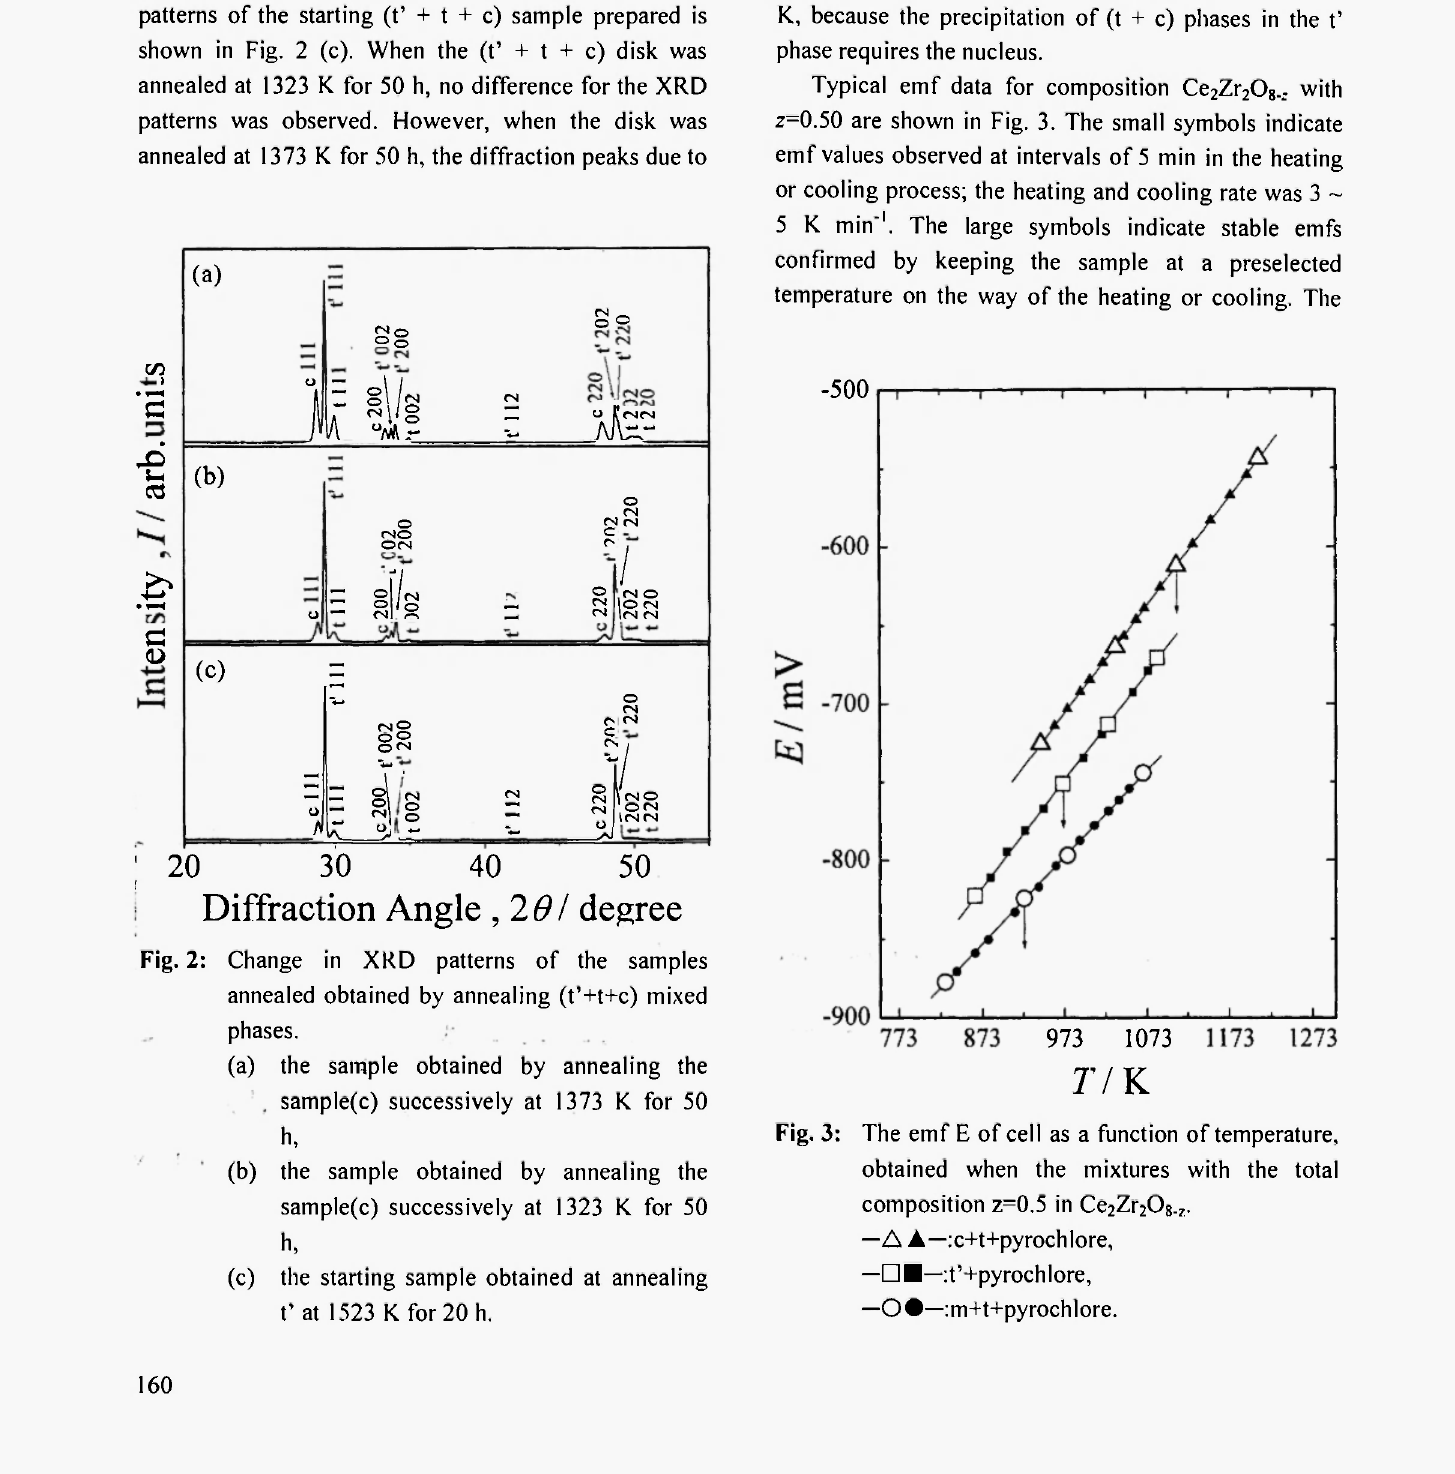
Fig. 3: The emf Ε of cell as a function of temperature, obtained when the mixtures with the total composition z=0.5 in Ce 2 Zr 2 0 8